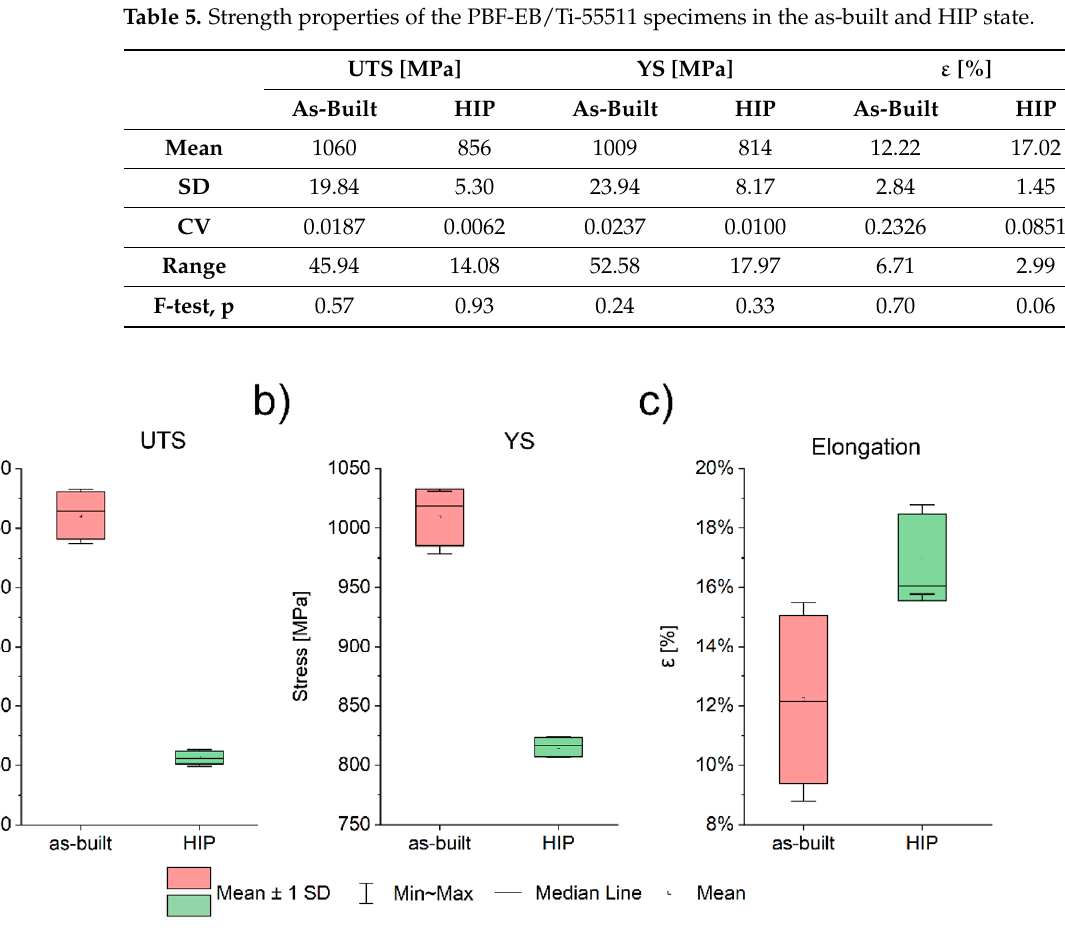
Table 5. Strength properties of the PBF-EB/Ti-55511 specimens in the as-built and HIP state.